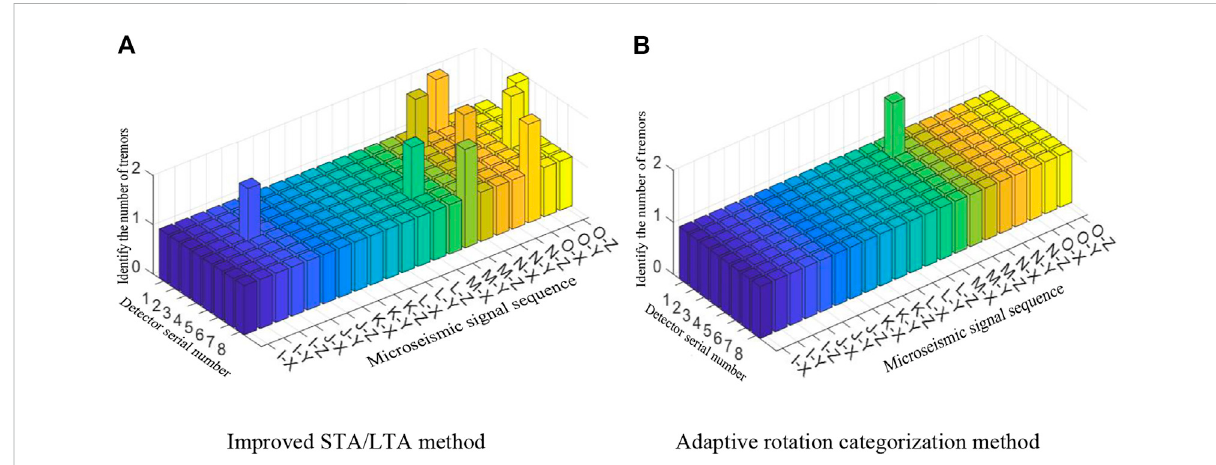
FIGURE 12 Microseismic phase identi fi cation results of the two methods.